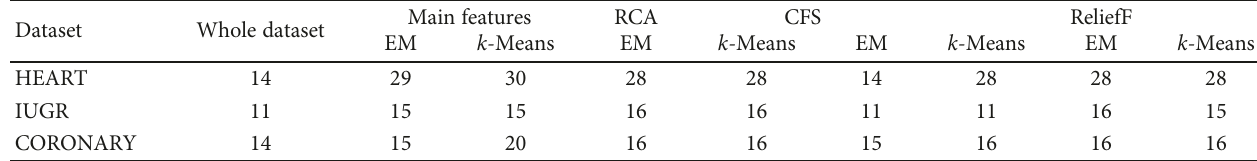
Table 7: Numbers of statistically signi fi cant correlations detected in the whole datasets and in clusters.